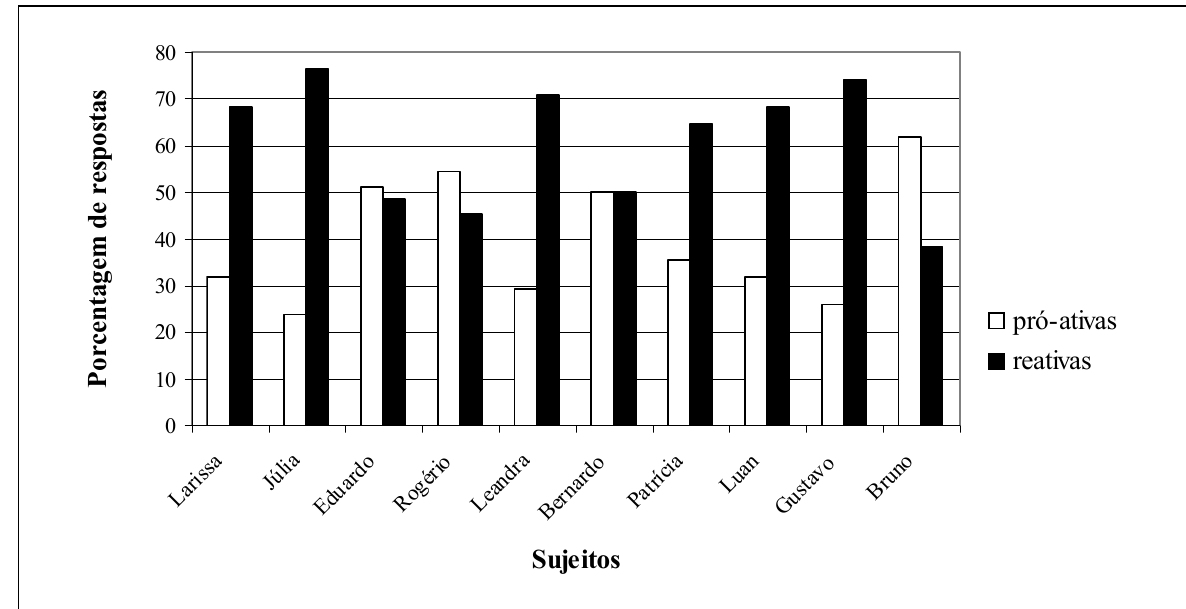
Figura 1. Porcentagem da freqüência de respostas pró-ativas e reativas no repertório dos participantes Figura 1 . Porcentagem da frequência de respostas pró-ativas e reativas no repertório dos sujeitos